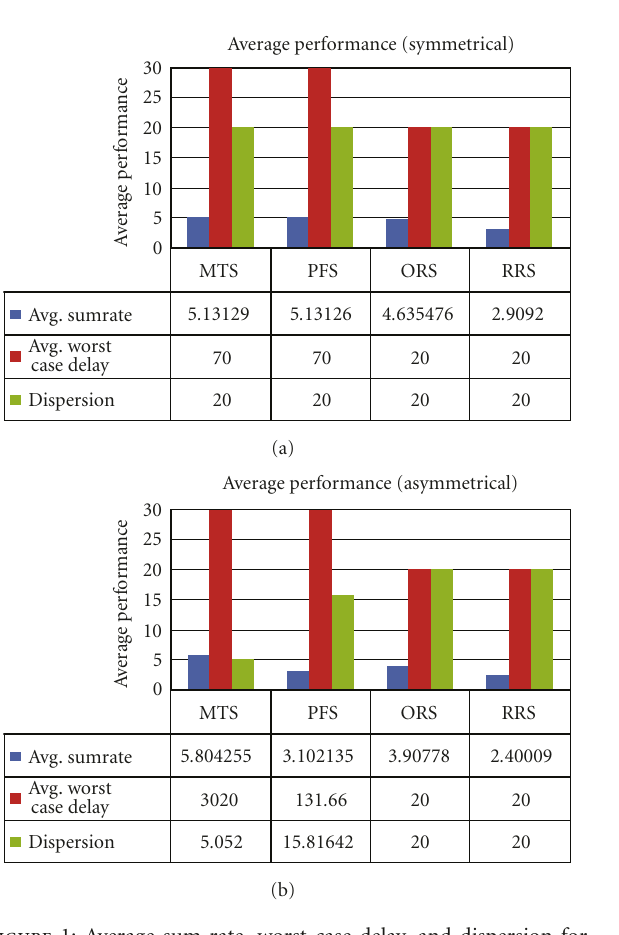
Figure 1: Average sum rate, worst-case delay, and dispersion for K = 20 symmetrically and asymmetrically distributed users.